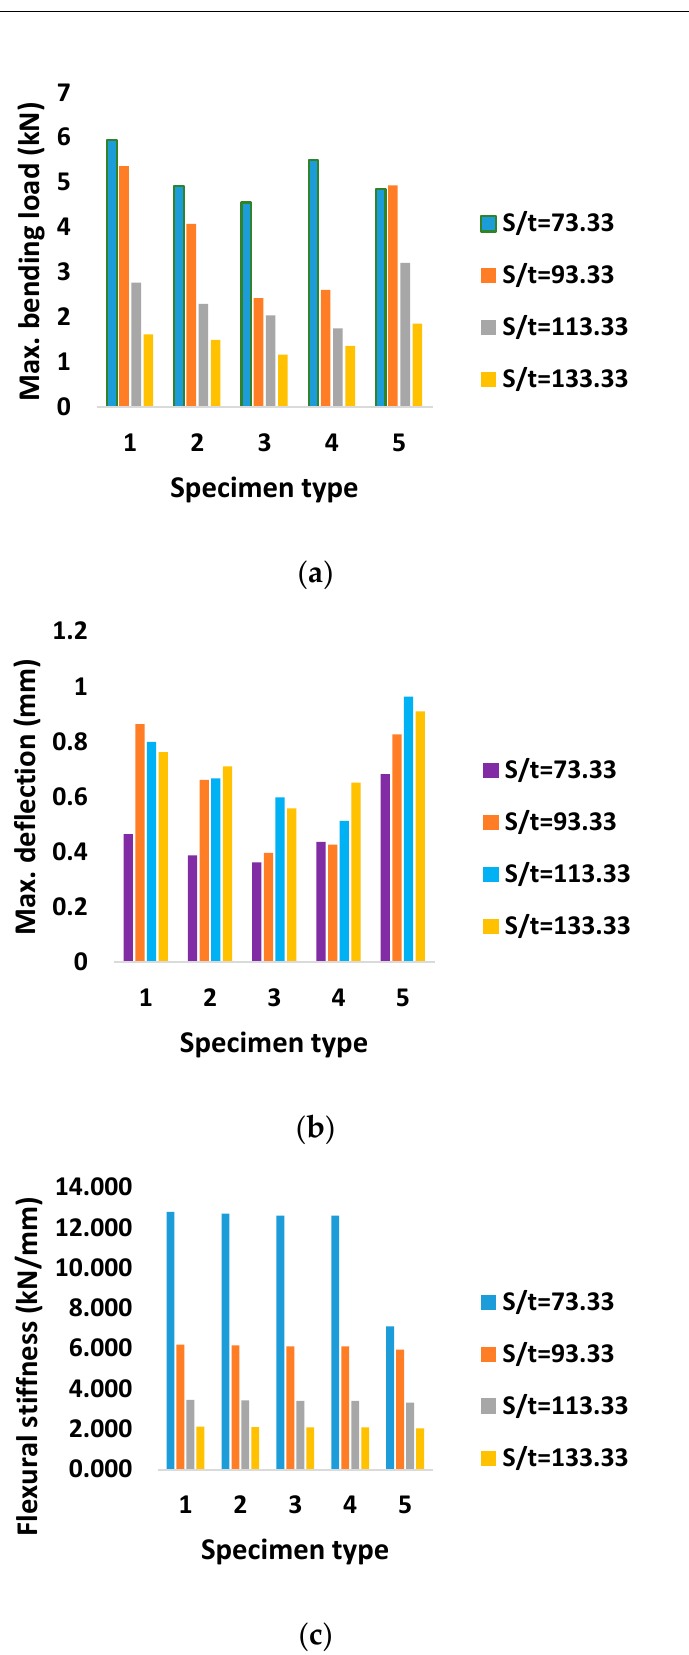
Figure 4. Numerical flexural performance measures ( a ) Maximum bending load ( b ) maximum deflection and ( c ) Flexural stiffness.